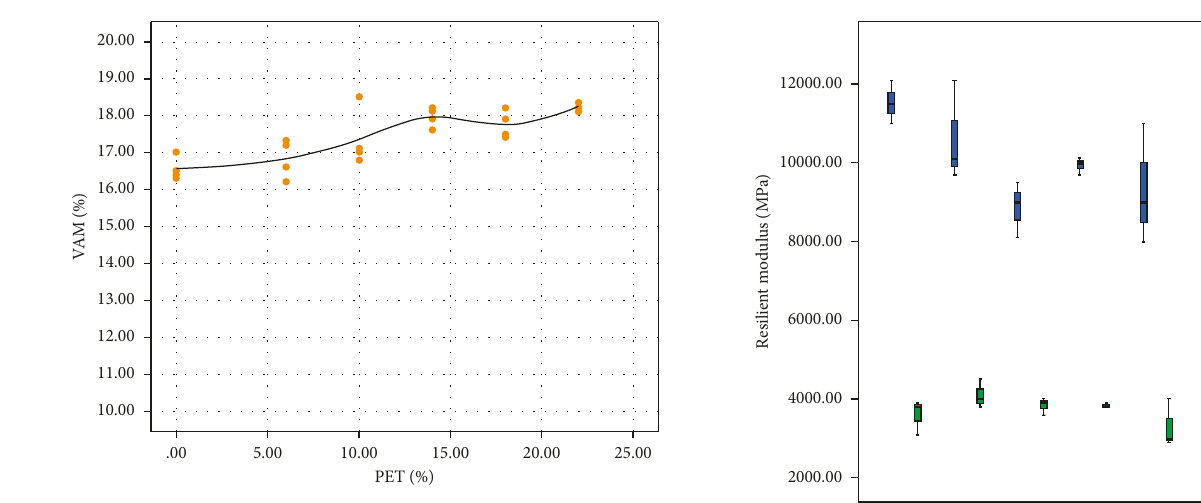
Figure 7: Percentage of air voids in the mineral aggregate.